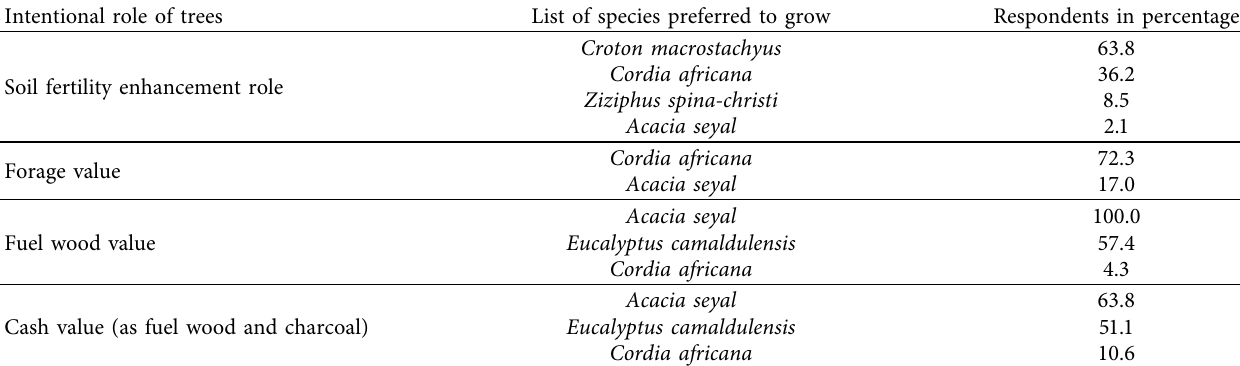
Table 5: Commonly grown tree species and their principal use.